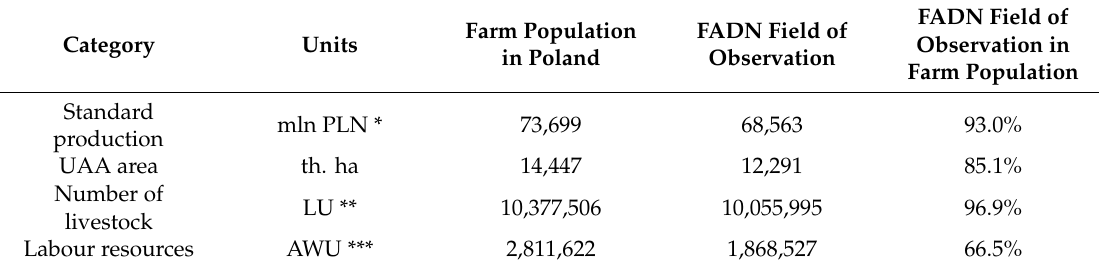
Table 1. The characteristic of the Farm Accountancy Data Network (FADN) sample in relation to the general population of Polish farms.